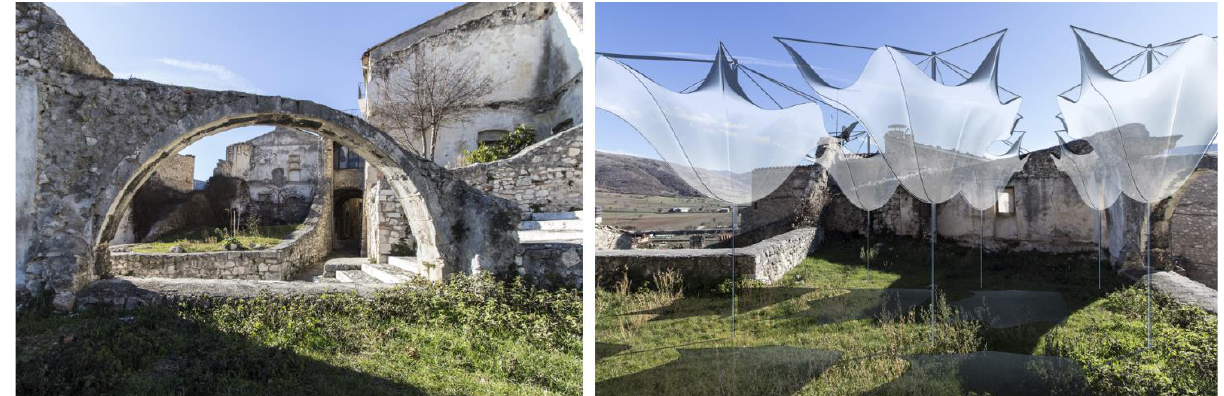
Figure 5. Re-designing an open space through adaptive umbrella covering